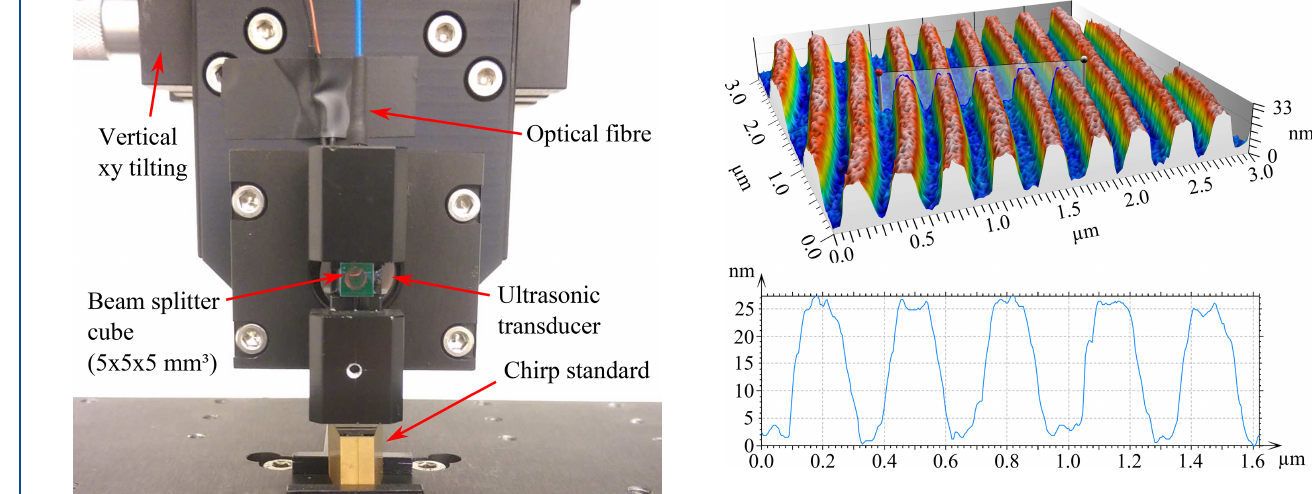
Figure 4. Topography and profile of a blank Blu-ray disc measured with the AFM (Hagemeier and Lehmann, 2018b).